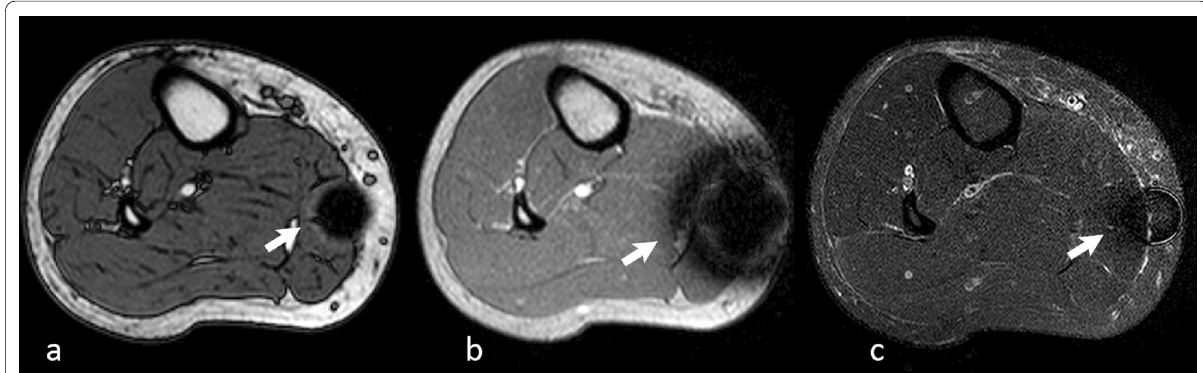
Fig. 11 Axial opposed-phase ( a ) and in-phase ( b ) gradient echo (GE) T1-w. and short inversion time inversion recovery (STIR) c series of the left leg in a 35-year-old patient with a distinct susceptibility artifact due to a superficial iron surgical clip (arrow). A marked enlargement of the metallic artifact is noted in the in-phase image [echo time (TE): 4.6 ms] compared to the opposed-phase image (TE: 2.3 ms). On STIR sequence (TE: 40 ms) the artifact is less evident despite the use of a longer TE, due to the use of multiple re-phasing 180° pulses (turbo spin echo factor: 20)